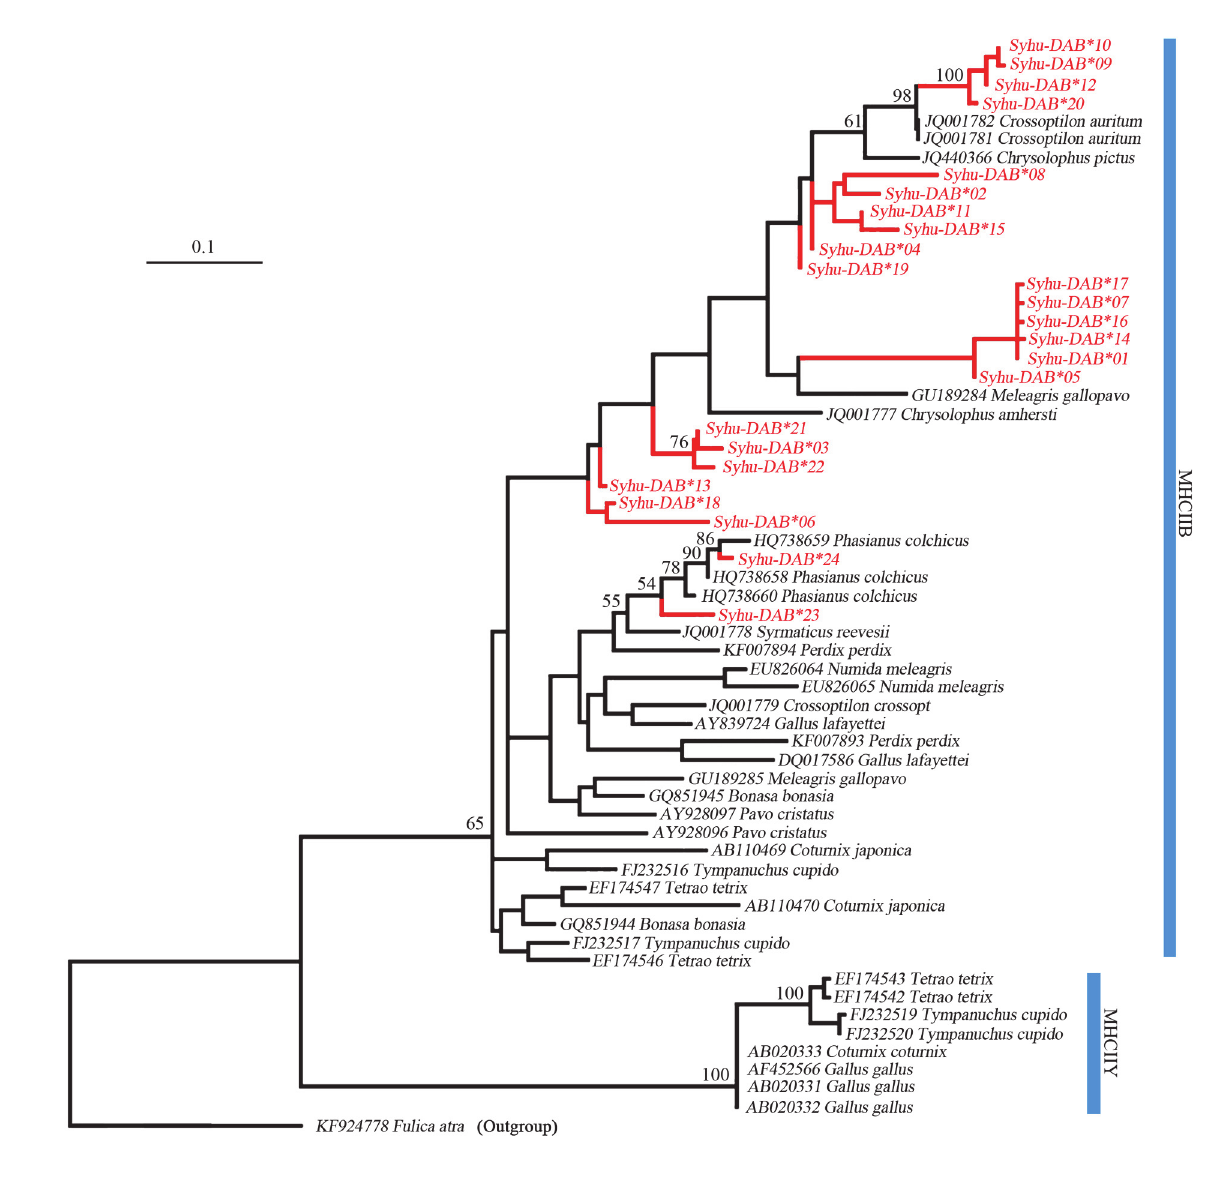
Figure 3. Maximum likelihood tree of exon 2 MHCIIB and MHCIIY sequences across galliform species. The sequence of DAB of the Eurasian coot ( Fulica atra ) (GenBank accession no.: KF924779)[32] was treated as an outgroup. Red color indicates MHCIIB exon 2 of Syrmaticus humiae . Only bootstrap values 50% were shown. For GenBank accession numbers and references see S2